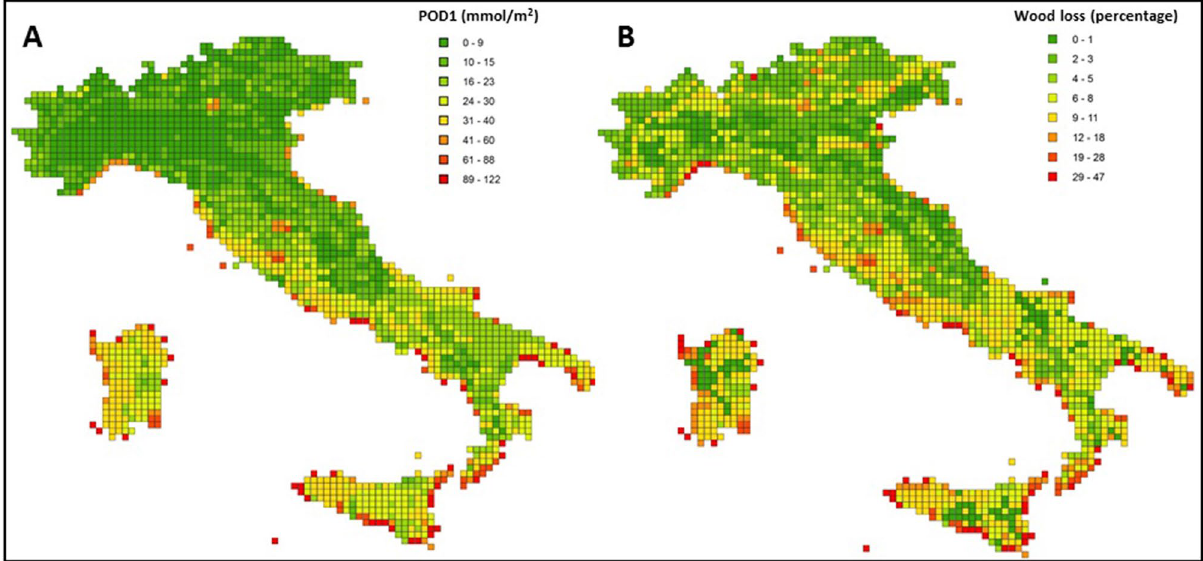
Figure 1. ( A ) Stomatal ozone uptake over a threshold of 1 nmol O 3 m −2 s −1 (POD1) and ( B ) wood loss (%) in the POD1 scenario relative to the no ozone damage scenario (WO) estimated over a 12 × 12 km grid along Italy in the year 2005. Maps were created by QGIS (https